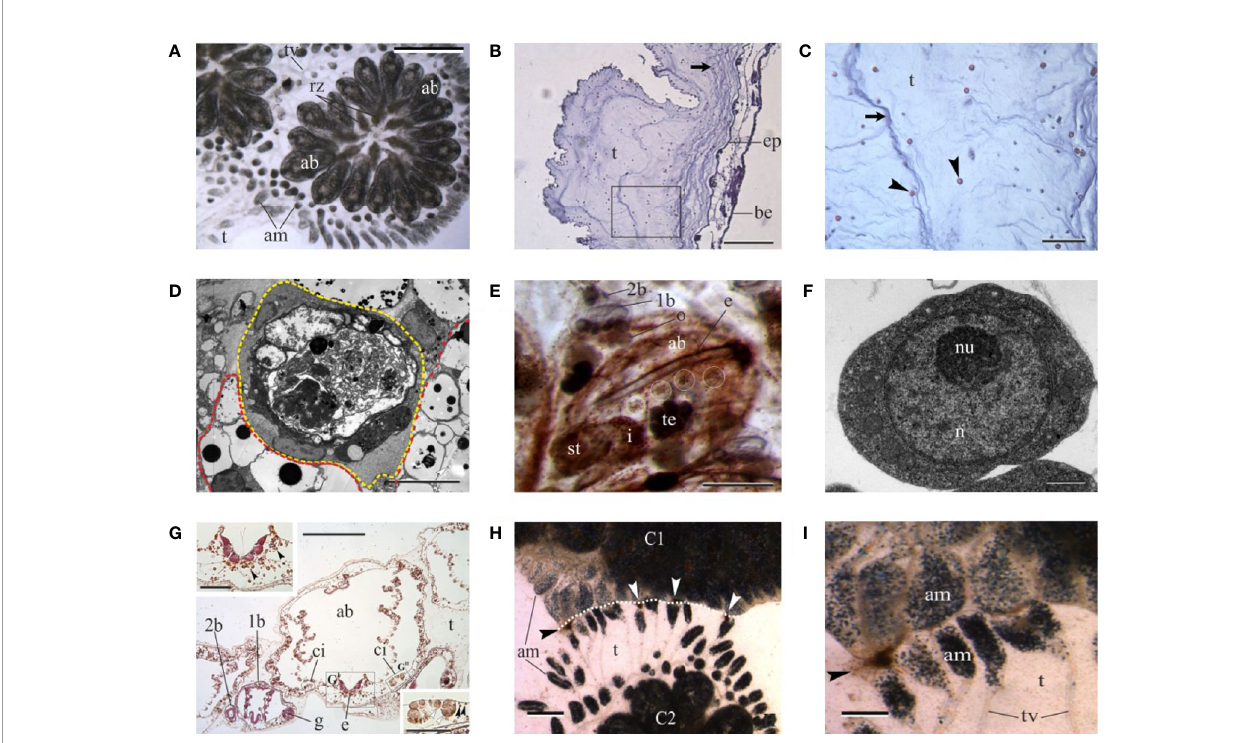
FIGURE 5 | (A) Colony of the tunicate ascidian Botryllus schlosseri . The colony has concluded the change of generation and adult blastozooids (ab) coexist together with regressing zooids (rz). am, blood ampullae in tunic; t, tunic; tv, tunic vessel. Dorsal view. Scale bar: 2.2 mm. (B, C) Histological sections of the tunic of the solitary ascidian Ciona robusta . Square area in (B) is enlarged in (C) to show tunic fi bers (arrows) and cells (arrowheads). Hematoxylin – eosin. be, branchial epithelium; ep, epidermis. Scale bar in B: 200 µm; in C: 50 µm. (D) Transmission electron microscopy of immunocytes in B. schlosser i. Yellow dotted line: large phagocyte with phagosomes of different size. Red dotted line: morula cells characterized by large vacuoles with an electrondense core. Scale bar: 10 µm. (E) Ventral view of an adult blastozooid (ab) of B. schlosseri with its primary bud (1b) bearing a secondary bud (2b). White circles label the cell islands in the left ventral body wall. Whole mount, ventral view; hematoxylin. o, oocyte in gonad rudiment in primary bud; i, intestine; st, stomach; te, testis. Scale bar: 500 µm. (F) Transmission electron microscopy of a candidate stem cells in B. schlosser i. n, nucleus; nu, nucleolus. Scale bar: 1 µm. (G) Transverse histological section of an adult blastozooid (ab) of B. schlosseri with its primary bud (1b). The latter bears a secondary bud (2b). The endostyle (e) niche and the cell island (ci) on the right are enlarged in upper left and bottom right insets, respectively. The contralateral cell island is contained by the black circle. Note in insets that small hemoblasts (black arrowheads) are recognizable in both the endostyle niche and in the cell island. In the latter, they are close to large phagocytes (white arrowheads). g, gonad rudimenti in primary bud; t, tunic. Hematoxylin – eosin. Scale bar in G: 200 µm; in G I -G II : 50 µm. (H, I) Regression between two incompatible colonies (C1 and C2) of B. schlosseri . Necrotic areas (arrowheads) are recognizable between the contacting tunics (white dotted line). am, blood ampullare; t, tunic; tv, tunic vessels. Scale bar in H: 1.2 mm; in I: 0.47